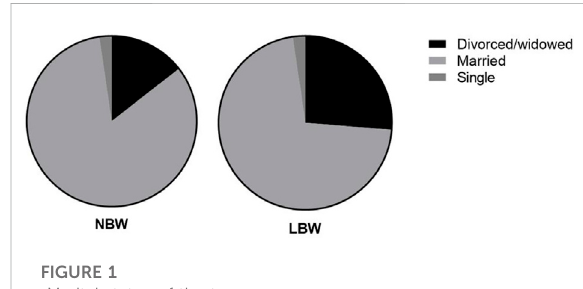
FIGURE 3 Blood pressure status of the two groups of